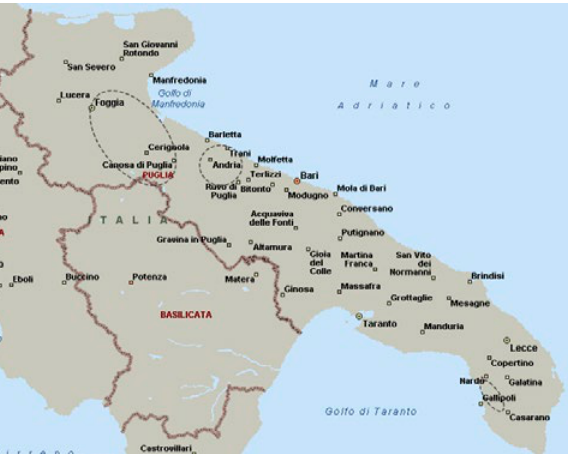
Figure 1. Map of the Apulia region of Italy showing the three locations where olive decline symptoms were here mentioned: Canosa di Puglia, Cerignola (Province of Bar- letta-Andria-Trani) and Foggia; Andria (Province of Bar- letta-Andria-Trani); Gallipoli (Lecce